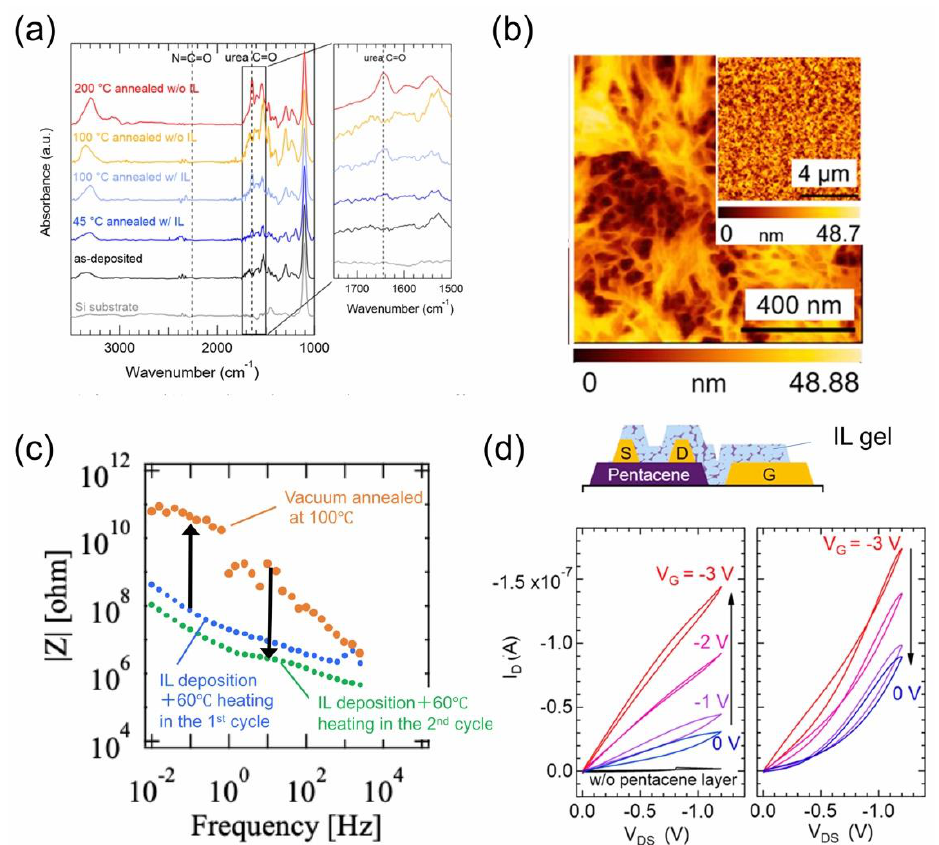
Figure 14. ( a ) IR absorption spectra of the urea films after vacuum annealing at different temperatures. ( b ) AFM image of a porous polyurea film via IL [emim][TFSA]. Reproduced with permission from ref. [69]. Copyright 2018, Elsevier. ( c ) Ion conduction behavior of an IL gel film, which was synthesized by the vacuum annealing (60 °C) of a 20 nm-thick bilayer consisting of 1:1 thickness ratio of urea and IL [emim][TFSA] films. ( d ) EDL transistor action of pentacene with a several tens nm-thick IL gel film as a gate electrolyte. Reproduced with permission from ref. [70]. Copyright 2020, American Chemical Society.